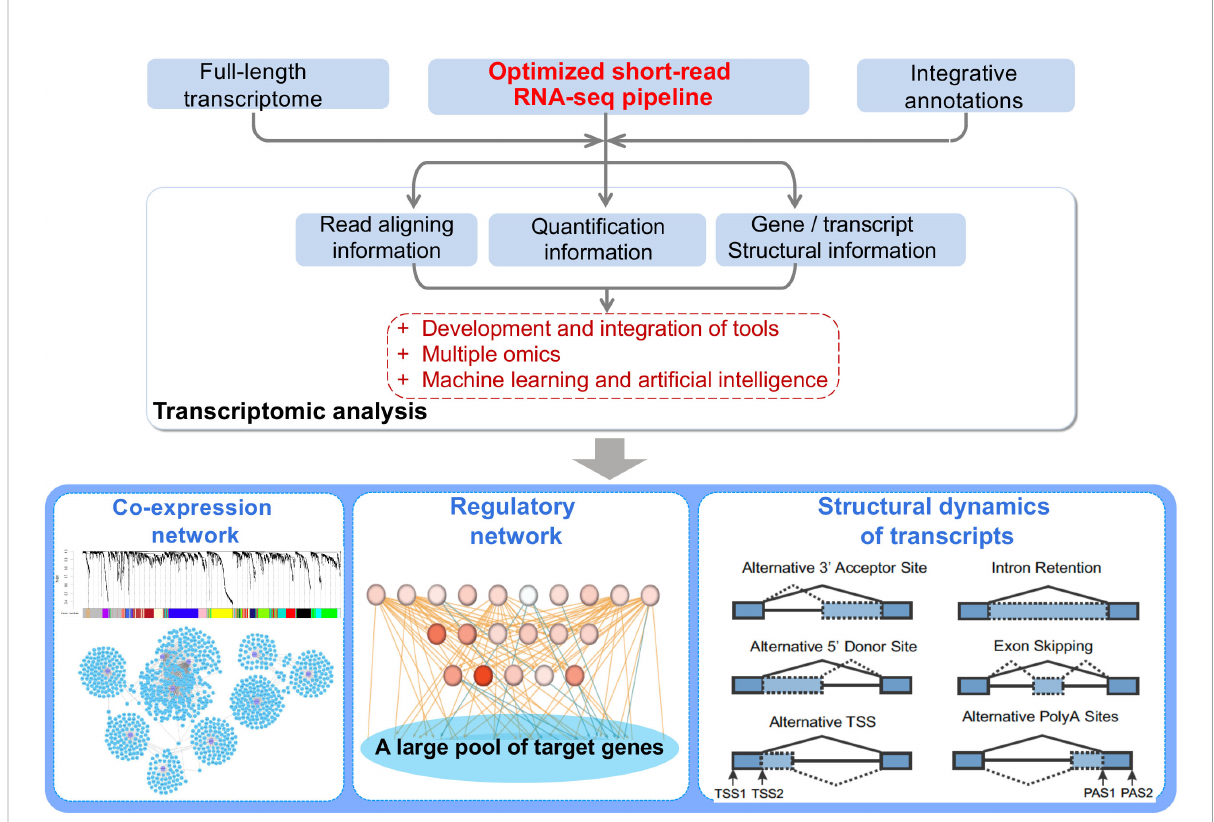
FIGURE 1 The power of short-read, bulk RNA-seq can be unleashed by integrating the following resources and tools related to RNA-seq analysis: (1) Full- length transcriptome can be achieved by full-length cDNA sequencing, PacBio Iso-seq or the Oxford Nanopore sequencing technologies, and these full-length transcriptomes can help to better annotate gene structures and serve as the basis for expression pro fi ling at the transcript- level. (2) For many less-studied plant species, multiple functional annotation resources can be applied to provide a comprehensive annotation, facilitating biological interpretation of sets of DEG or gene networks. (3) Through application of the tools introduced here and in previous reviews, high-quality GCNs and GRNs can be made to prioritize hub genes or key regulators involved in the certain biological process or